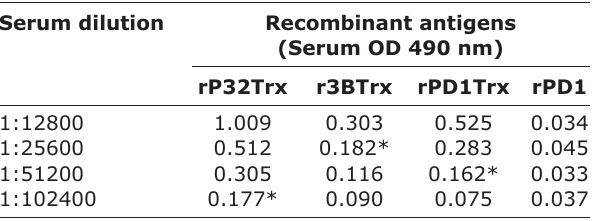
Table-3: Determination of the cross-reactivity of anti-thioredoxin serum antibodies from immunized mice. Serum dilution